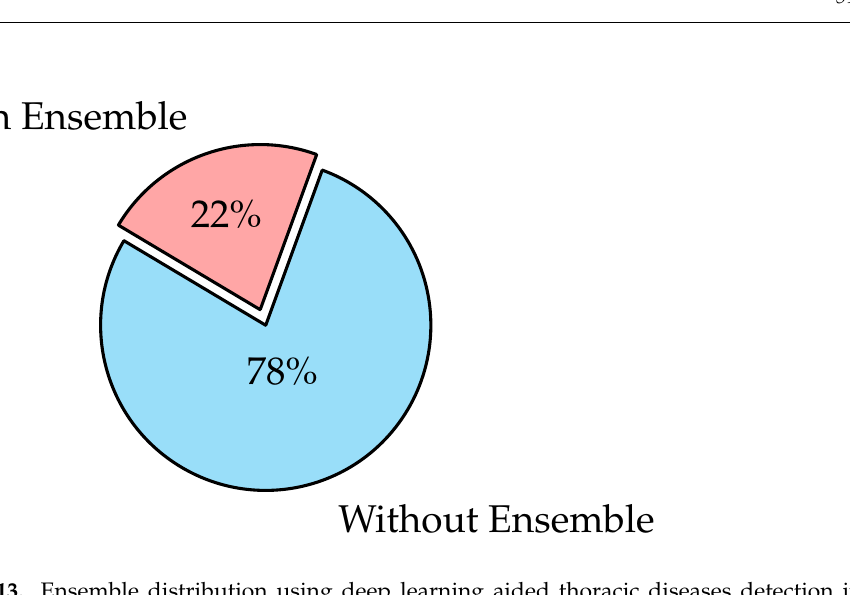
Figure 13. Ensemble distribution using deep learning aided thoracic diseases detection in the recent years.